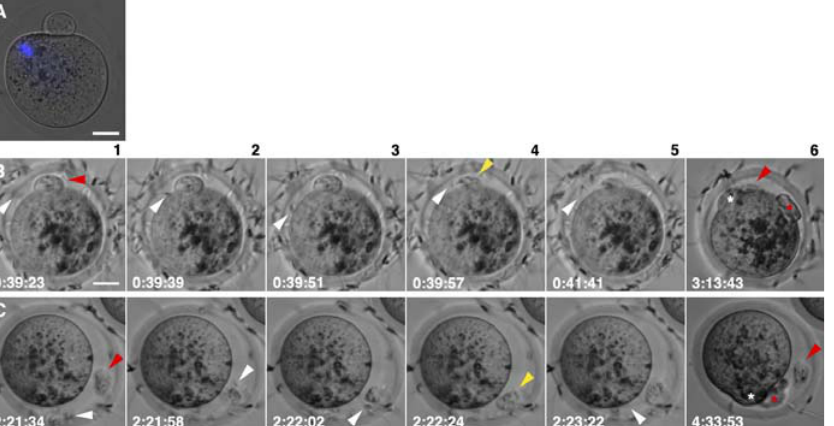
Figure 3. Sperm Swims Around within the PVS Prior to Fertilization (A) Typical morphology of a MII oocyte with the meiotic chromosomes located in one ‘‘ shoulder. ’’ (B and C) Sequential DIC (differential interference contrast) images of embryos during in vitro fertilization. (1) Sperm penetrates the ZP. (2 and 3) Sperm swims around the PVS. (4) Sperm hits the 1pb. (5) Sperm binds the oocyte membrane. (6) 2pb extrudes and the fertilization cone forms. White arrowheads indicate the sperm, red arrowheads the 1pb, and yellow arrowheads the collapsing (B) or rotating (C) 1pb. White and red asterisks mark the fertilization cone and the 2pb, respectively. Scale bars in (A) and (B1) represent 20 l m. DOI: 10.1371/journal.pbio.0040135.g003 PLoS Biology |